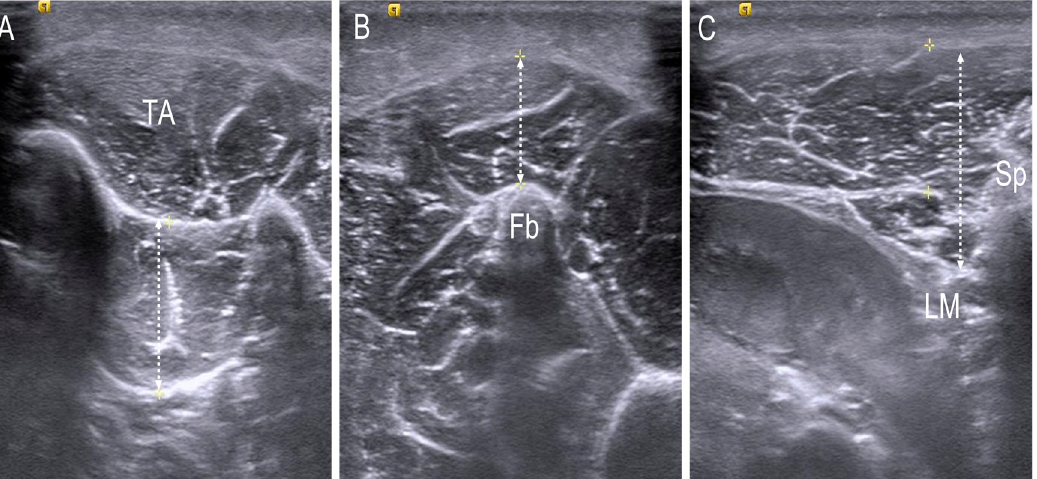
Figure 4. Anterior–posterior measurement of ( A ) tibialis posterior muscle; ( B ) peroneus longus muscle and ( C ) L1 Multifidus in the transverse scan. TA; tibialis anterior, Fb; fibula, LM; lamina, Sp; spinous process .